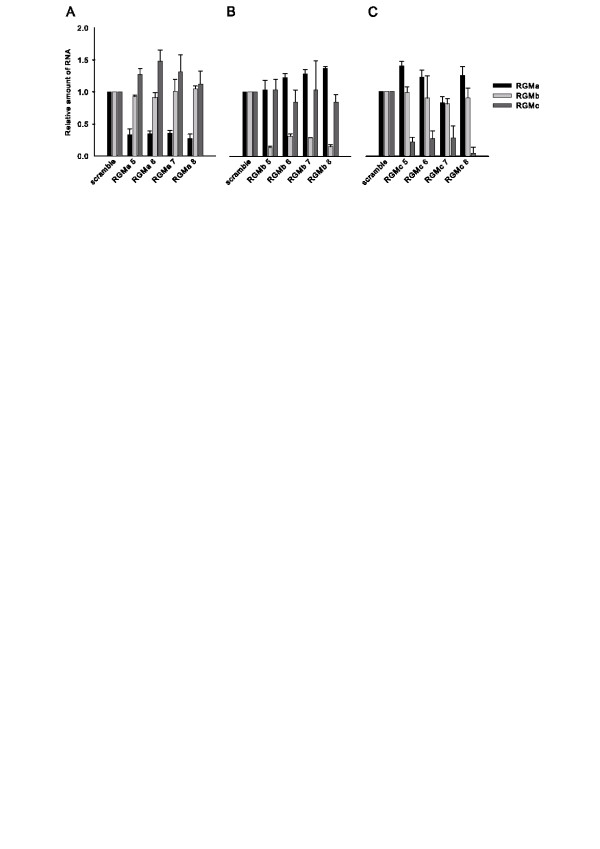
Relative RNA levels for each RGM after siRNA mediated knockdown. Real-time quantitative Taqman RT-PCR analysis was performed to test the effectiveness and specificity of RNA target knockdown in cells transfected with siRNA duplexes. A scramble control was tested in addition to four distinct siRNA duplexes that target RGMa (A), RGMb (B), or RGMc (C). Error bars represent the standard deviation (n = 4).